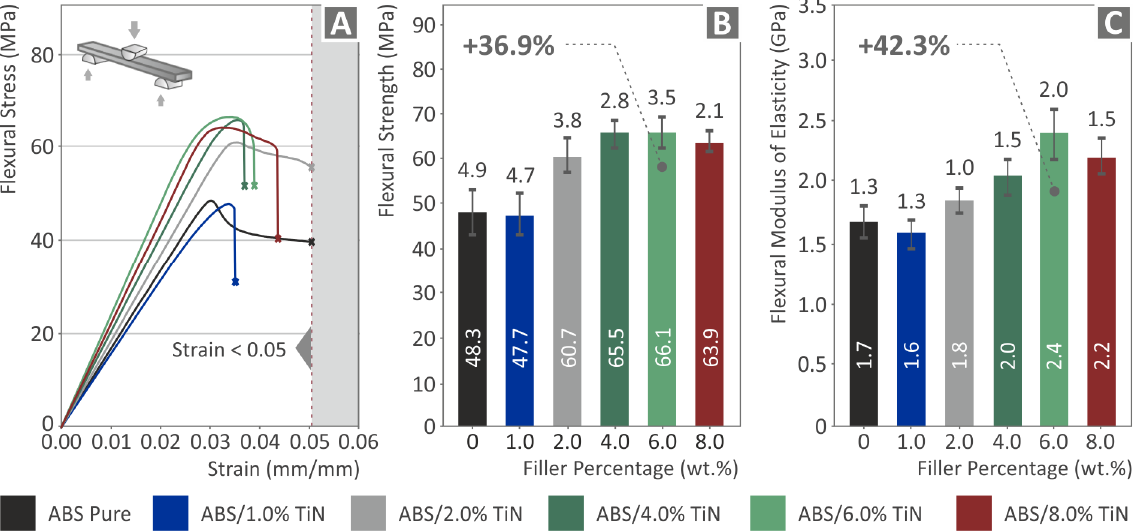
Figure 9. Flexural tests of the six 3D-printed specimens: ( A ) flexural stress vs. strain graph of one randomly selected specimen of the five tested in each nano compound (experiment termination: 5% strain, as per the ASTM D790 standard), average values and deviation of the ( B ) flexural strength results and ( C ) flexural modulus of elasticity results.